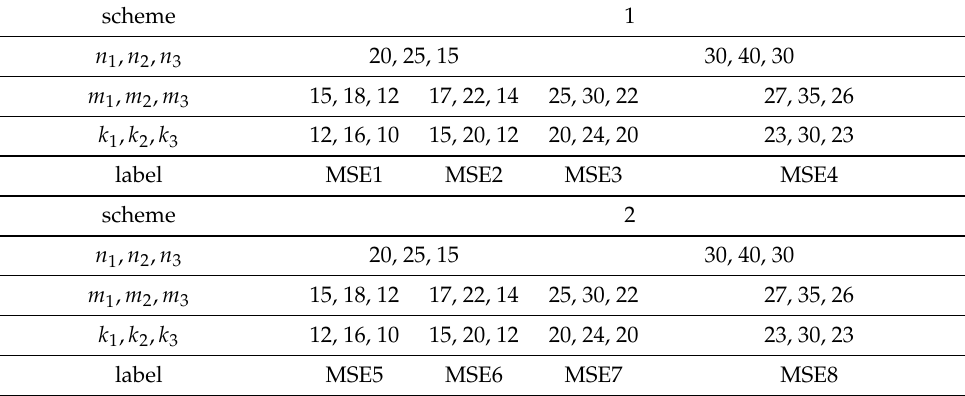
Table 1. Labels of MSE results for heatmaps plots.